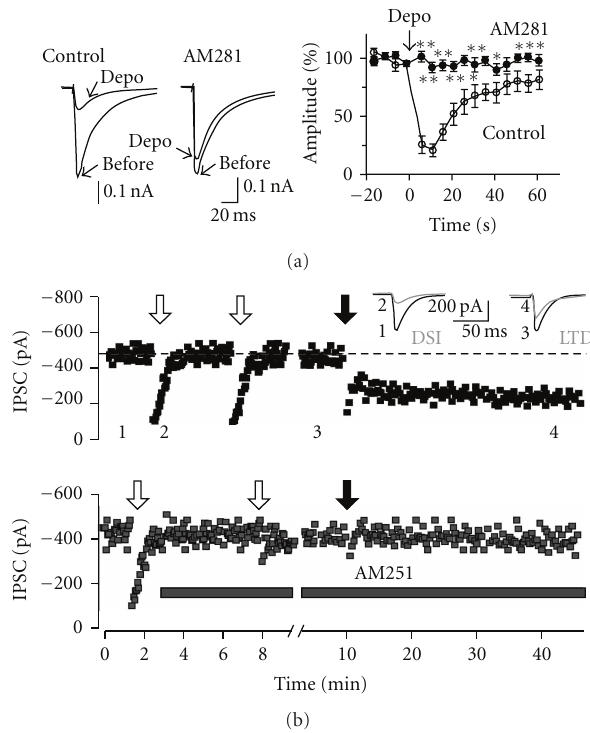
Figure 3: Endocannabinoid-dependent plasticity of GABAergic synapses . (a) In cultured hippocampal neurons, eCBs mediate a form of short-term retrograde signaling strongly reducing GABAer- gic responses. This can be observed by the reduction of unitary inhibitory postsynaptic currents (IPSCs) evoked after a 5 sec- long depolarization (depo) of the postsynaptic neuron. The CB1R antagonist AM281 blocked the depolarization-induced suppression of inhibition (DSI). Time course of DSI is indicated in the right panel. Modified from [105]. For details, see reference [105, 106]. (b) Time course of extracellularly evoked IPSC amplitude in the CA1 area of the hippocampus. Brief depolarizations (white arrows) of the recorded pyramidal cell induce DSI (see Figure 3), whereas high-frequency stimulation (black arrow) of a ff erent fibers induces LTD of GABAergic responses. Traces correspond to the time points indicated by numbers in the upper graph. Both DSI and LTD induction are blocked by the selective CB1R antagonist AM251 (gray bar, lower graph). Modified with permission from